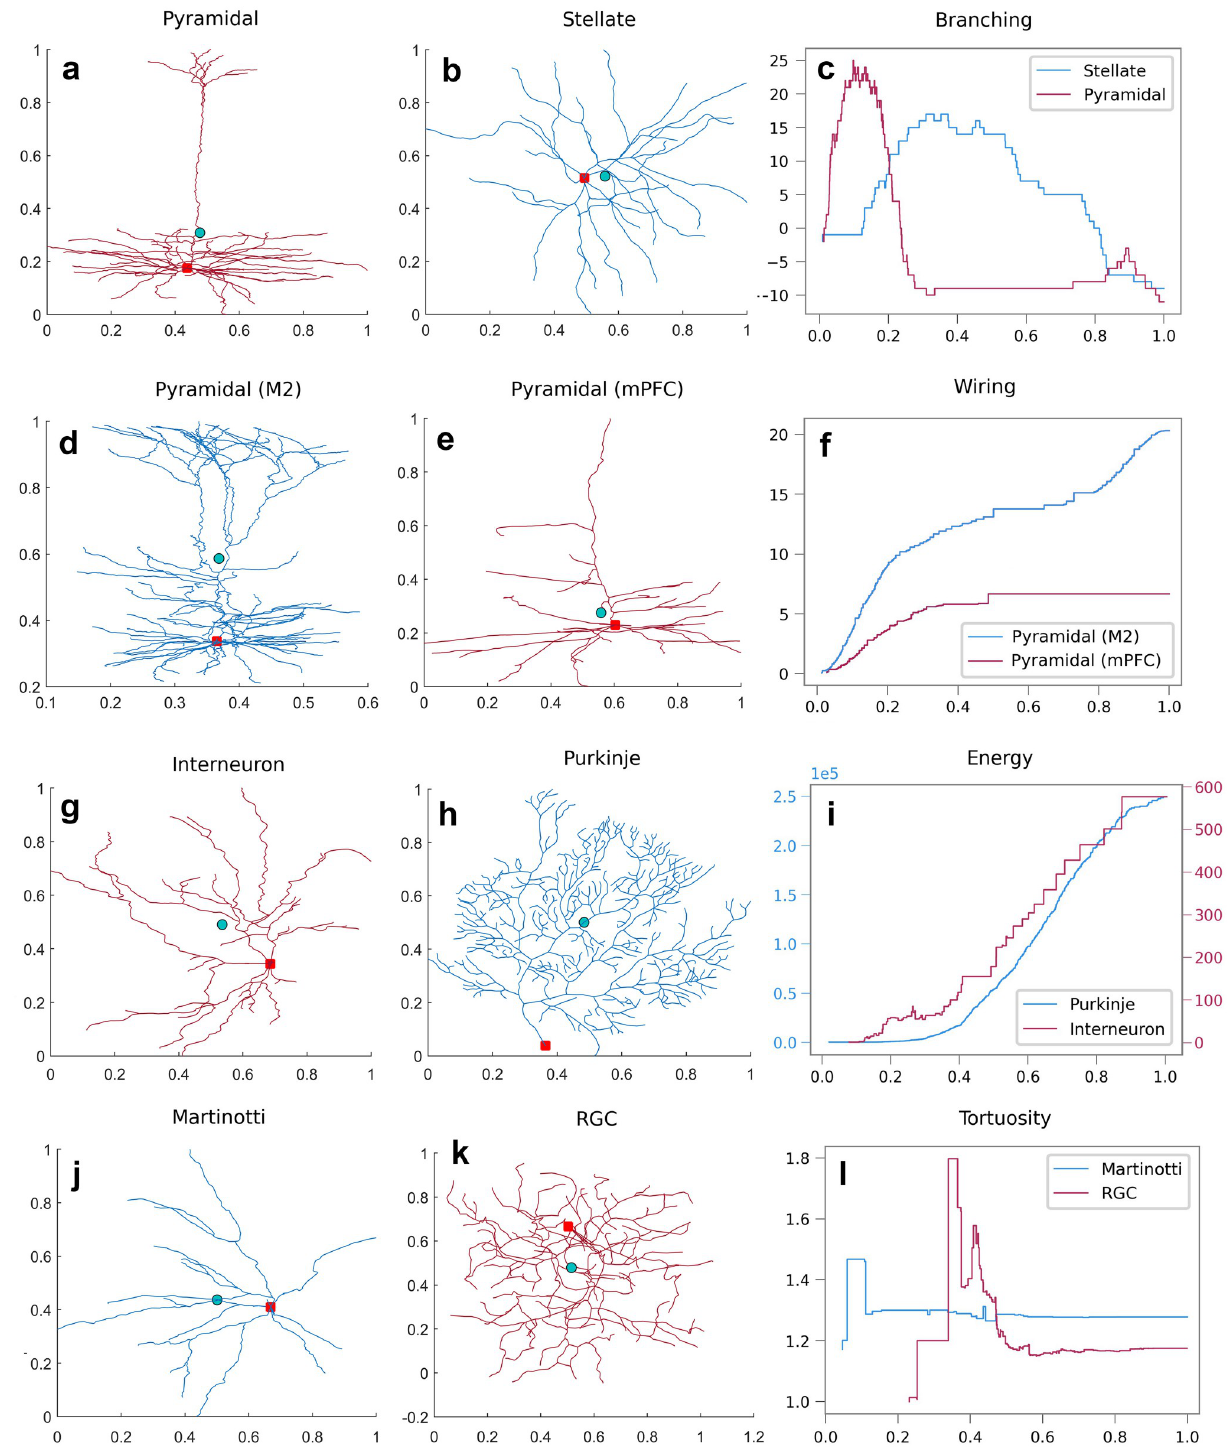
Fig 4. Representative neurons and their corresponding step functions. ( a ) Pyramidal and ( b ) stellate cell. ( c ) The step functions for each neuron generated from the branching pattern Sholl descriptor. The branching Sholl functions show that neuron ( a ) is branching quickly near the soma, and leaves appear much closer to the soma than for neuron ( b ). The number of primary branches for each neuron is the value of the corresponding function at 1. ( d ) Pyramidal cell in secondary motor cortex (M2) and ( e ) in medial prefrontal cortex (mPFC). ( f ) The step functions for neurons ( d ) and ( e ) generated from the wiring Sholl descriptor. The sharp increase towards the end for the wiring Sholl function for cell d . reveals the existence of an apical